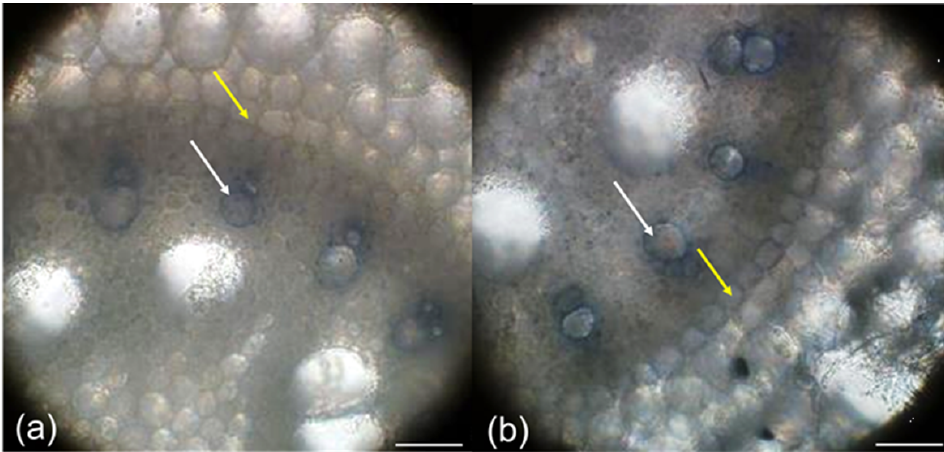
Figure 4. In situ POX activity in the maize roots (hybrid Bielik) after 3 days of cultivation in the paper rolls as control ( a ) or treated with PAW ( b ). The hand cross sections were 10% from the root apex and stained with 4 MN. The arrows point at the endodermis (yellow) and early metaxylem (white). Scale bars 100 µm.